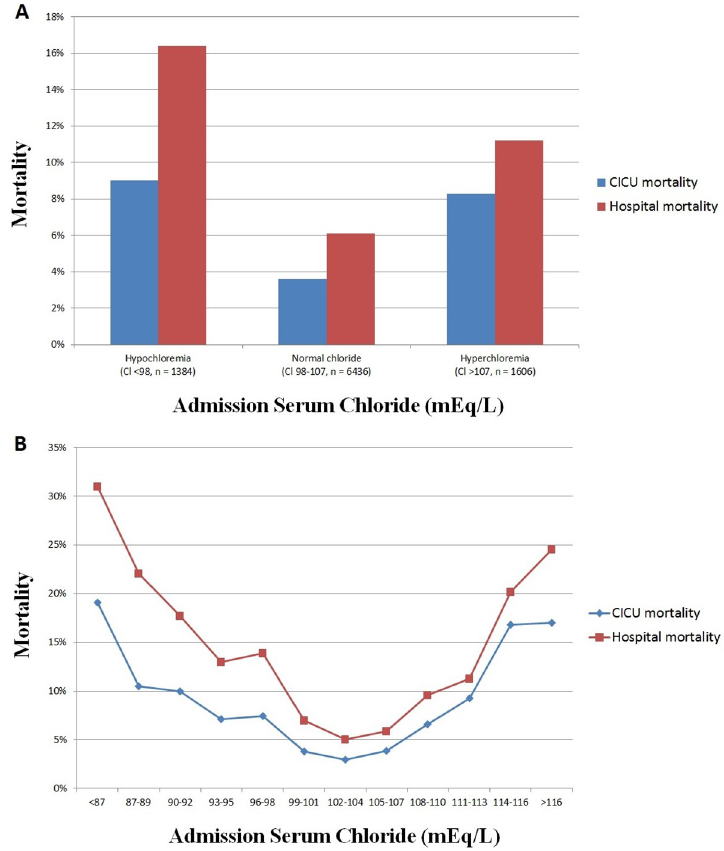
Fig 1. CICU and hospital mortality and admission chloride level in the overall population, based on the presence of admission hypochloremia or hyperchloremia (A) or as a function of admission chloride level (B). Hypochloremia is defined as chloride < 98 mEq/L and hyperchloremia is defined as chloride � 108